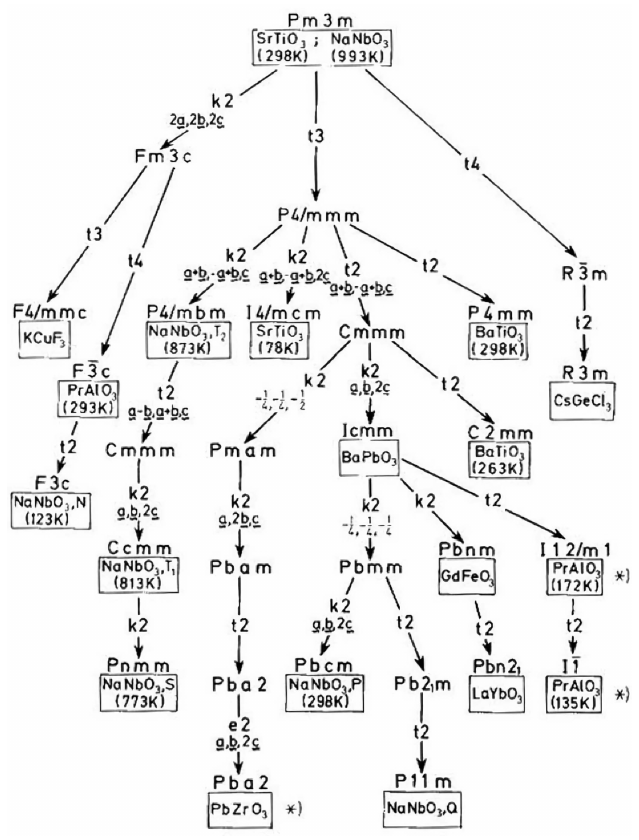
Figure 2 Ba¨rnighausen’s (1975) original ‘family tree’ of